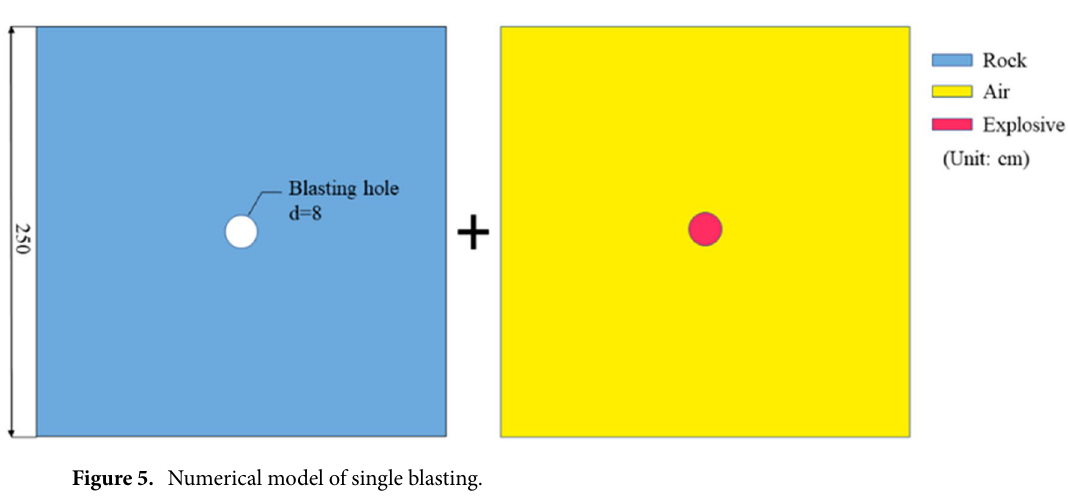
Figure 5. Numerical model of single